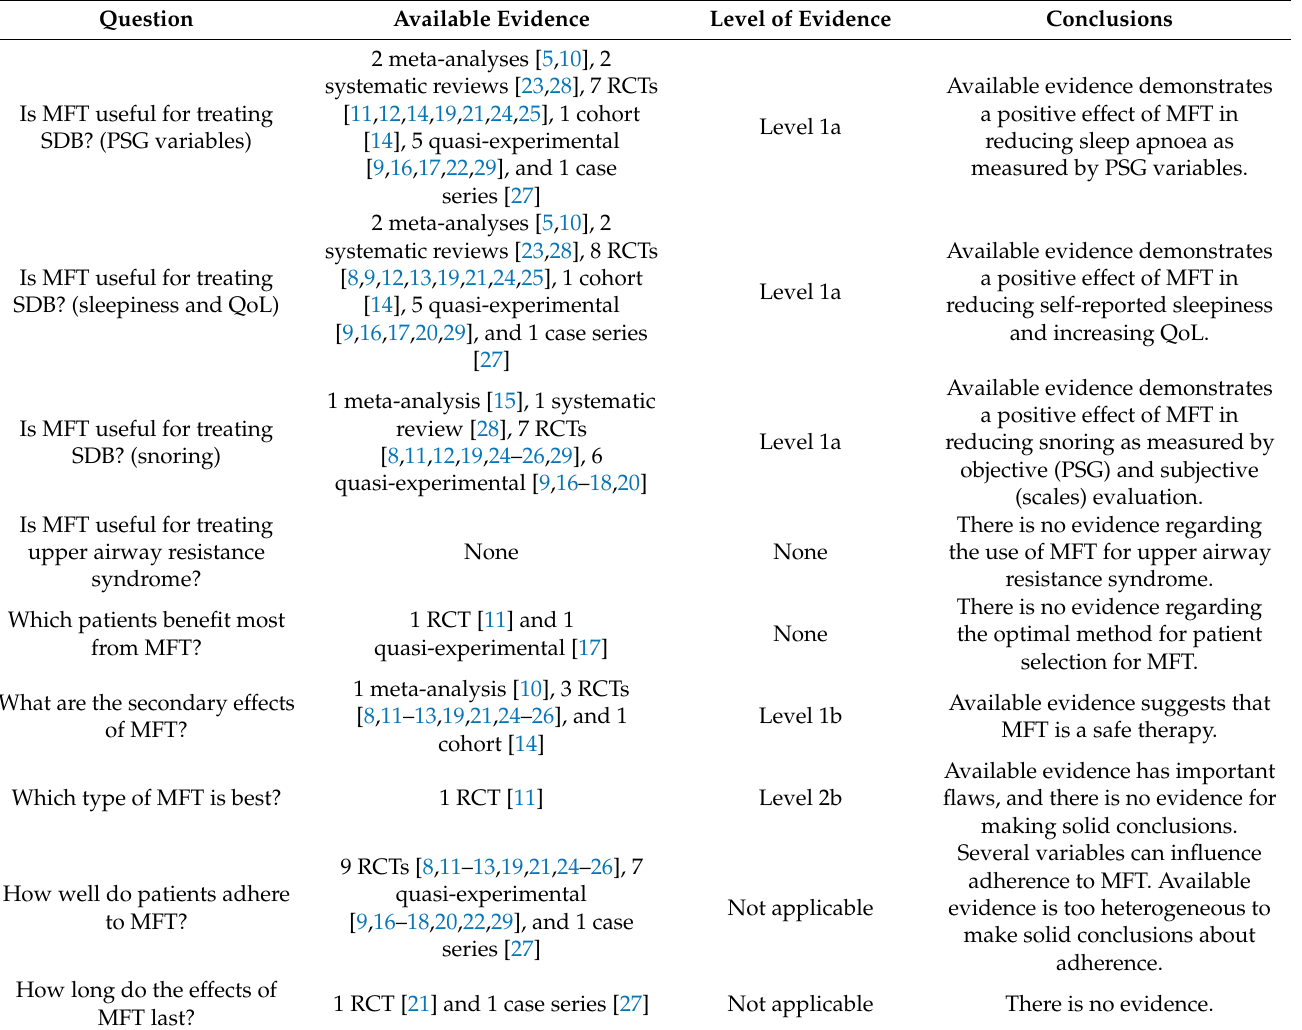
Table 1. Summary of the